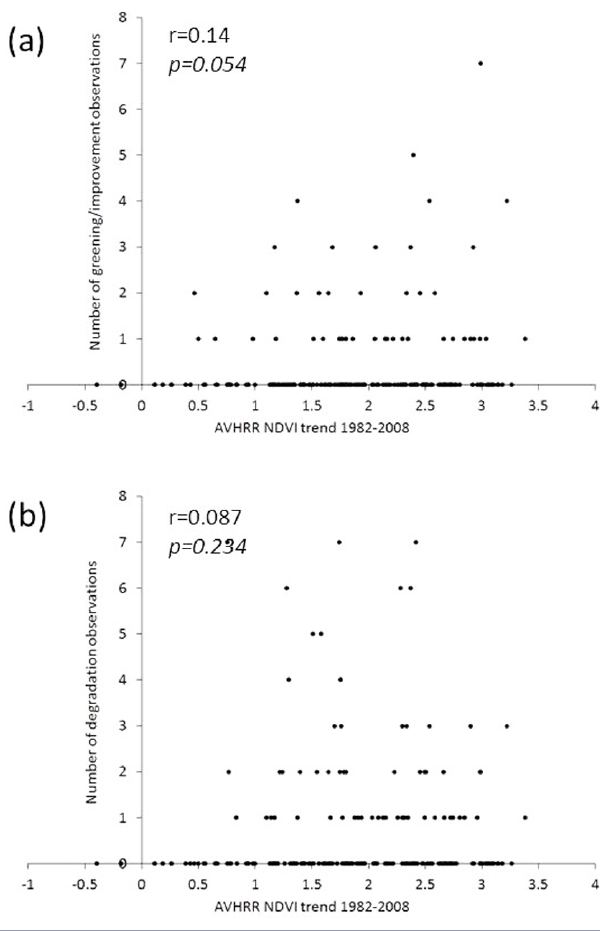
Fig. 5. Scatterplots indicating the correlation of transhumants’ perceptions of improvement or degradation of vegetaton with the remote sensing observations of trends in NDVI. (a) Geening/improvement of vegetation cover. (b) Degradation of vegetation cover. The NDVI is a unitless measure of vegetation greenness. Trends in NDVI (x-axes) are the slopes of the linear regression rescaled by 1000.